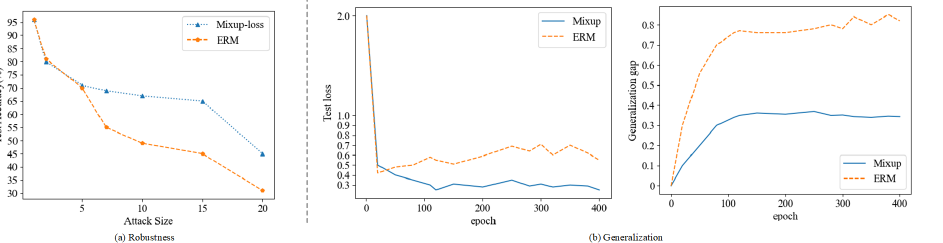
Figure 6. Exemplary examples of the impact of Mixup on robustness and generalizability. ( a ) Ad- versarial robustness of SVHN data under FGSM attack. ( b ) Generalization gap between test and training